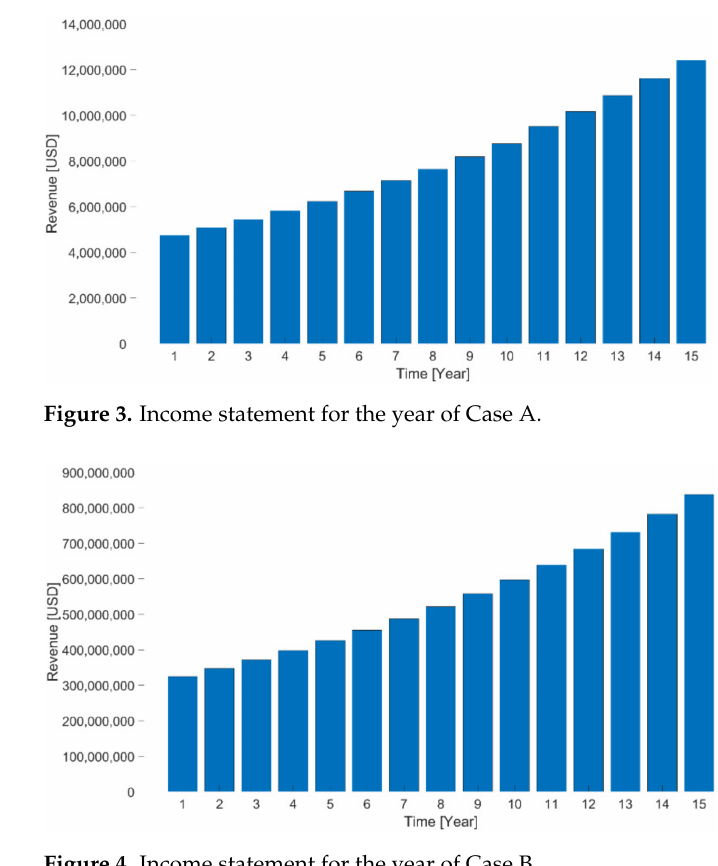
Figure 4. Income statement for the year of Case